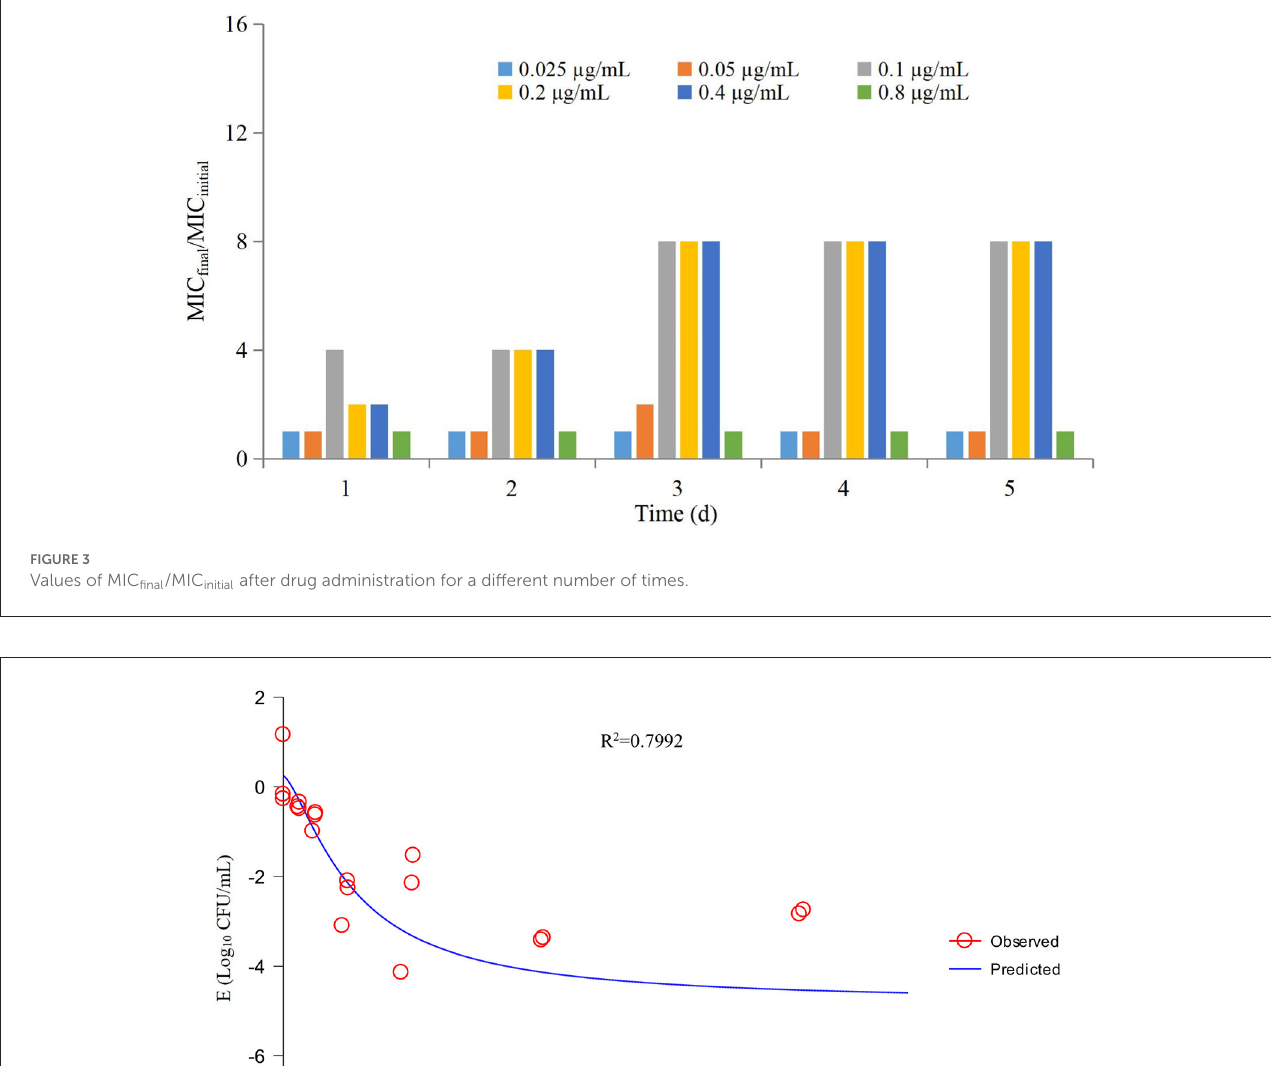
Figure 2. The antibacterial effect after each dose is shown in